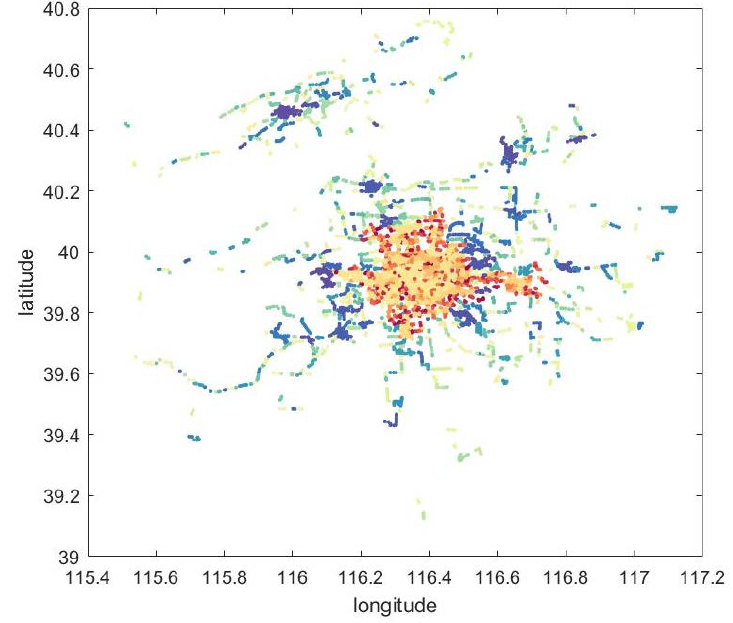
Figure 7. Result of OD area division (points in the same color means stops in one area).